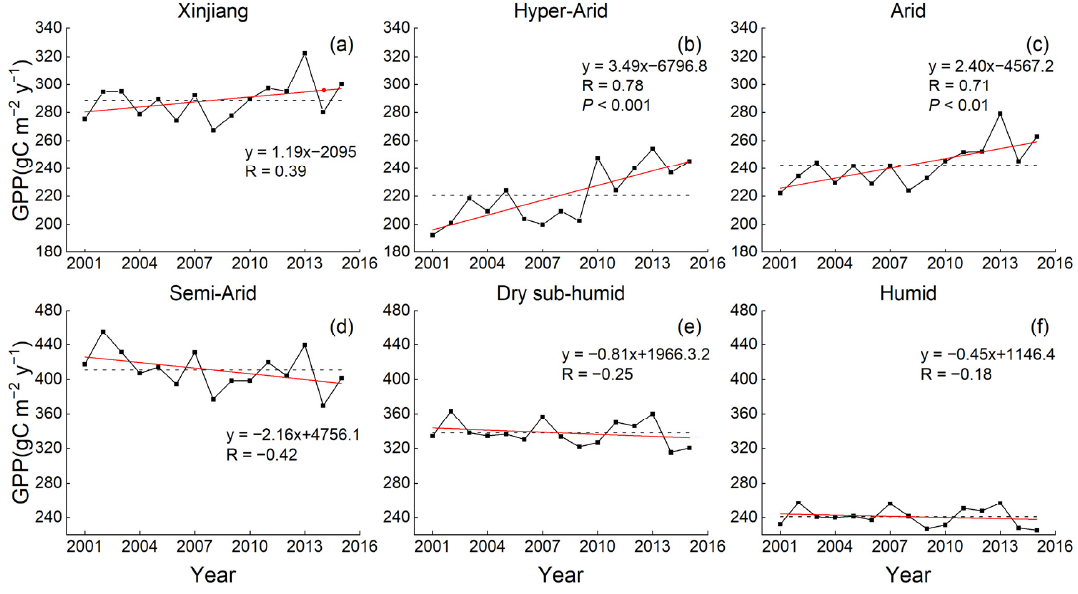
Figure 7. Inter-annual variations in GPP in different climate zones from 2001 to 2015 are shown for ( a ) the entire Xinjiang region, ( b ) hyper-arid region, ( c ) arid region, ( d ) semi-arid region, ( e ) dry sub-humid region, and ( f ) humid